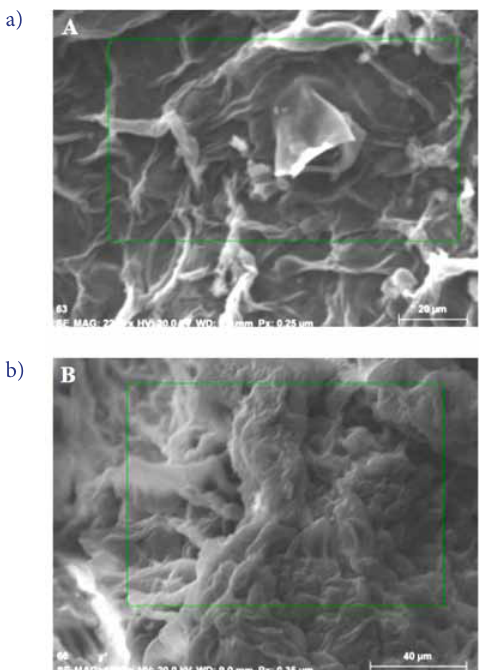
Fig. 2. (a) SEM images of tobacco leaf before biosorption (b) SEM images of tobacco leaf after biosorption